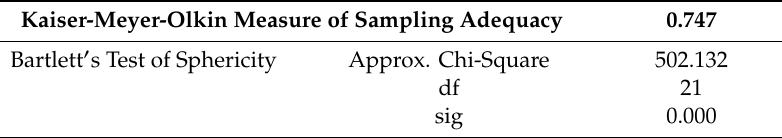
Table 5. KMO test and Bartlett sphericity test.